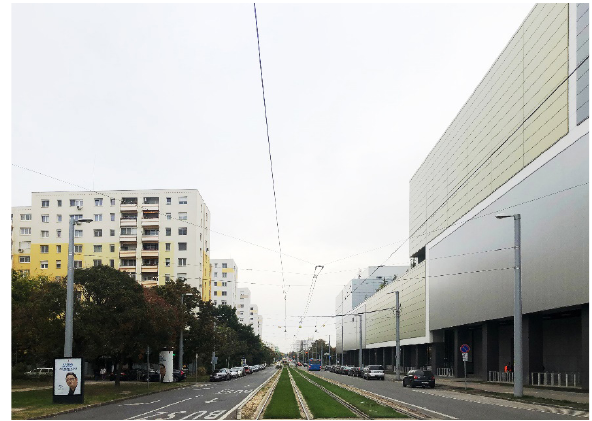
Figure 9. Etele street view: Kelenföld LHE with renovated panel slabs and the ETELE shopping mall opened in 2021 (source: author)